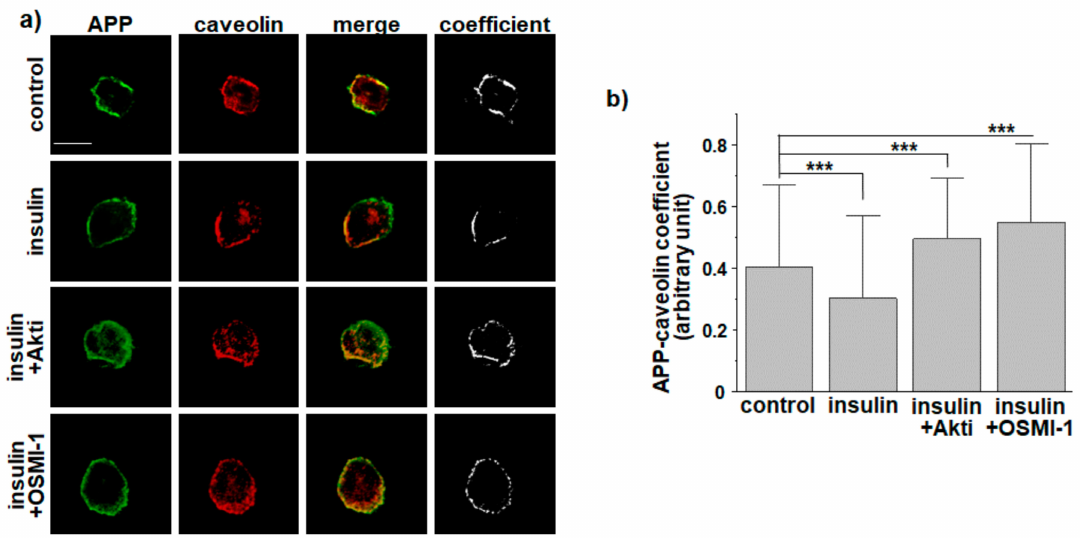
Figure 1. Insulin reduces APP localization in lipid raft microdomains. SH-SY5Y-APP/BACE1 cells were incubated with 1 µ M insulin for 2 h. Akt inhibitor (Akti, 10 µ M) or OGT inhibitor (OSMI-1, 50 µ M) was also used. After washing, cells were incubated with 6E10 antibody at 4 ◦ C to label APP at the plasma membrane. Cells were then fixed, permeabilized, and incubated with caveolin antibody to label lipid rafts. Fluorescent conjugated secondary antibodies were used. ( a ) Typical immunoreactivities of APP (green) and caveolin (red) are shown. ( b ) Coefficients of APP and caveolin were quantified as arbitrary units using Zen software ( n = 40, number of cells were randomly selected from four independent experiments). The threshold was automatically set as the 60100% value. (Mander’s M1 coefficient: control, 0.4025 ± 0.01967; insulin, 0.30248 ± 0.01868; Akti, 0.49505 ± 0.01759; OSMI-1, 0.55038 ± 0.02195; fraction of A overlapping B, image A: APP, image B: caveolin). Scale bar is 10 µ m. One-way ANOVA: ***, p < 0.001. All values represent the mean ±